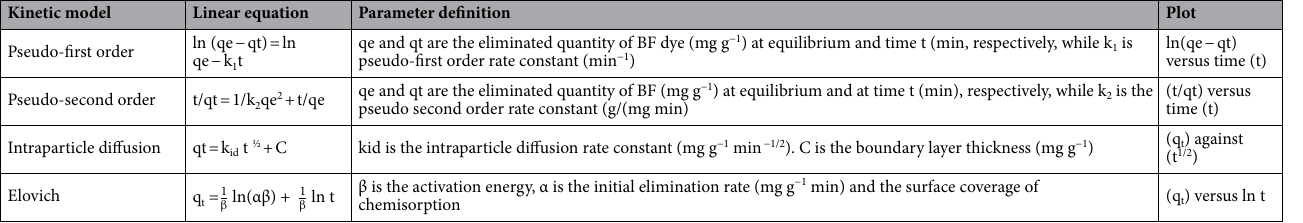
Table 3. Evaluated kinetic models for biosorptive removal of BF dye by Gel@GO-F-ZrSiO 4